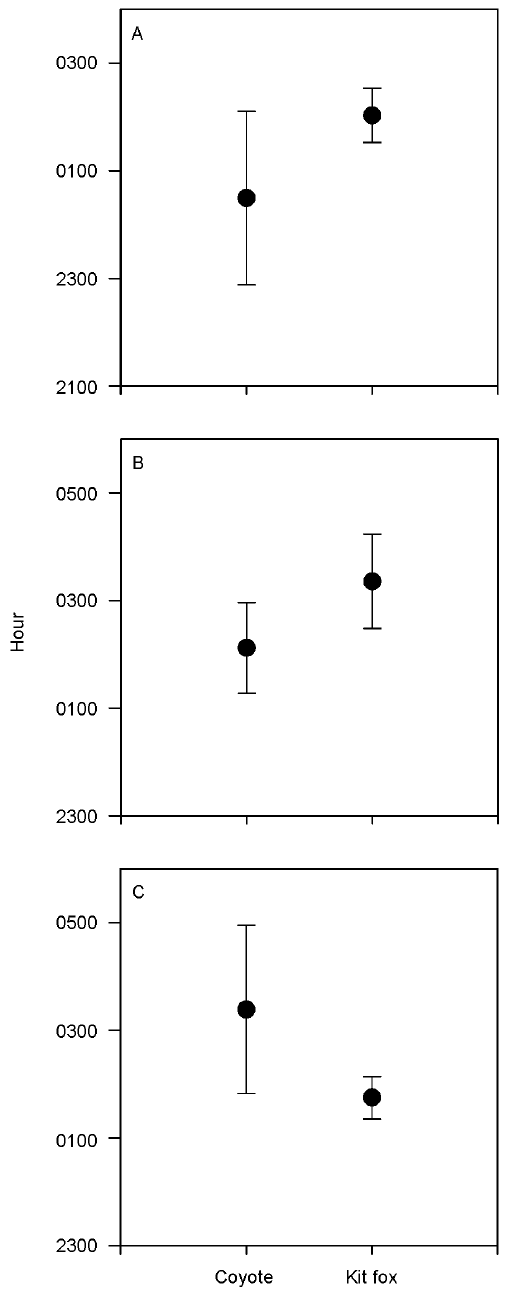
Figure 5. Mean times of day ( 6 SE) when canids visited scent stations. Temporal visitation patterns were observed for coyotes ( Canis latrans ) and kit foxes ( Vulpes macrotis ) in A) Mojave during 2011, B) Great Basin during 2012, and C) Mojave during 2012.